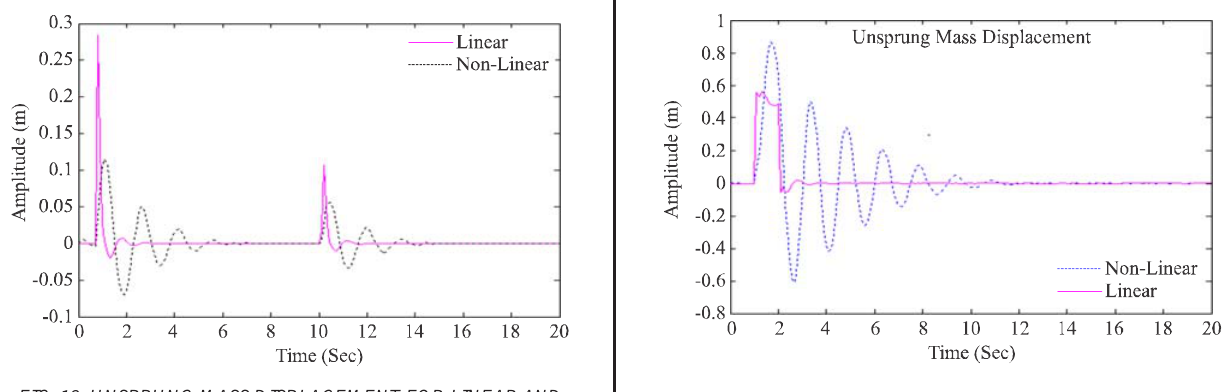
FIG. 12. UNSPRUNG MASS DISPLACEMENT FOR STEP